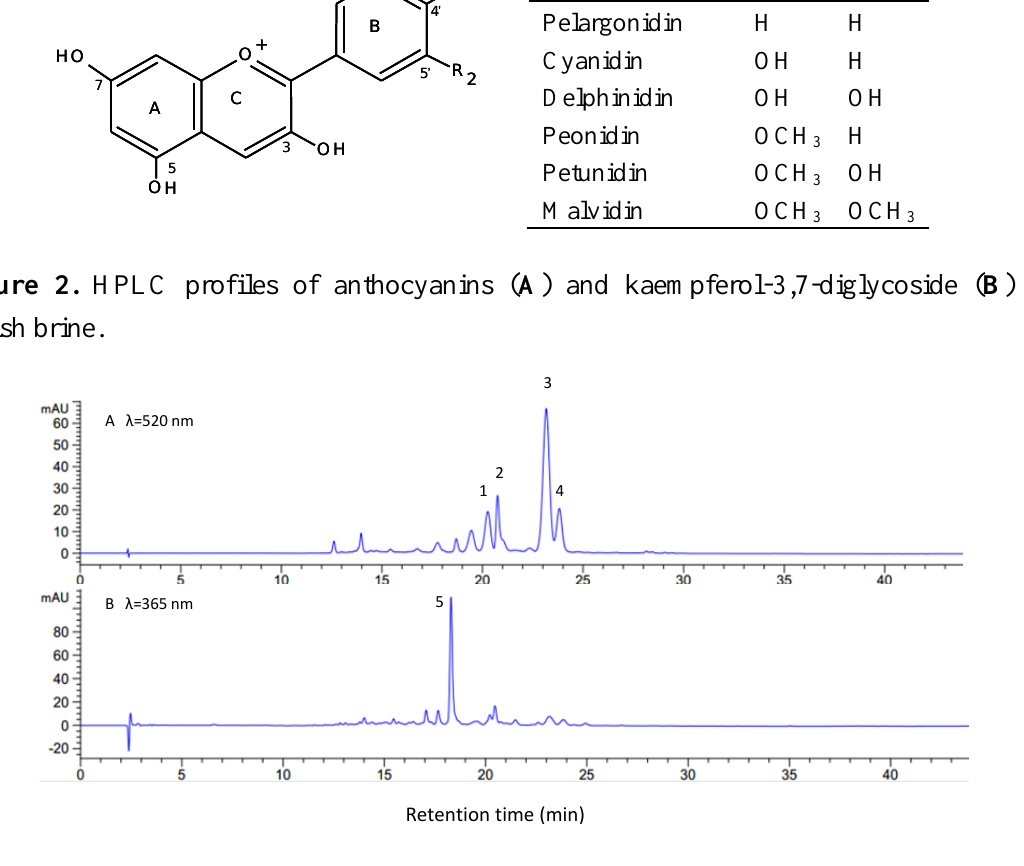
Table 2. Qualitative analyses of anthocyanins and kaempferol derivatives in radish brine after fermentation with Lactobacillus